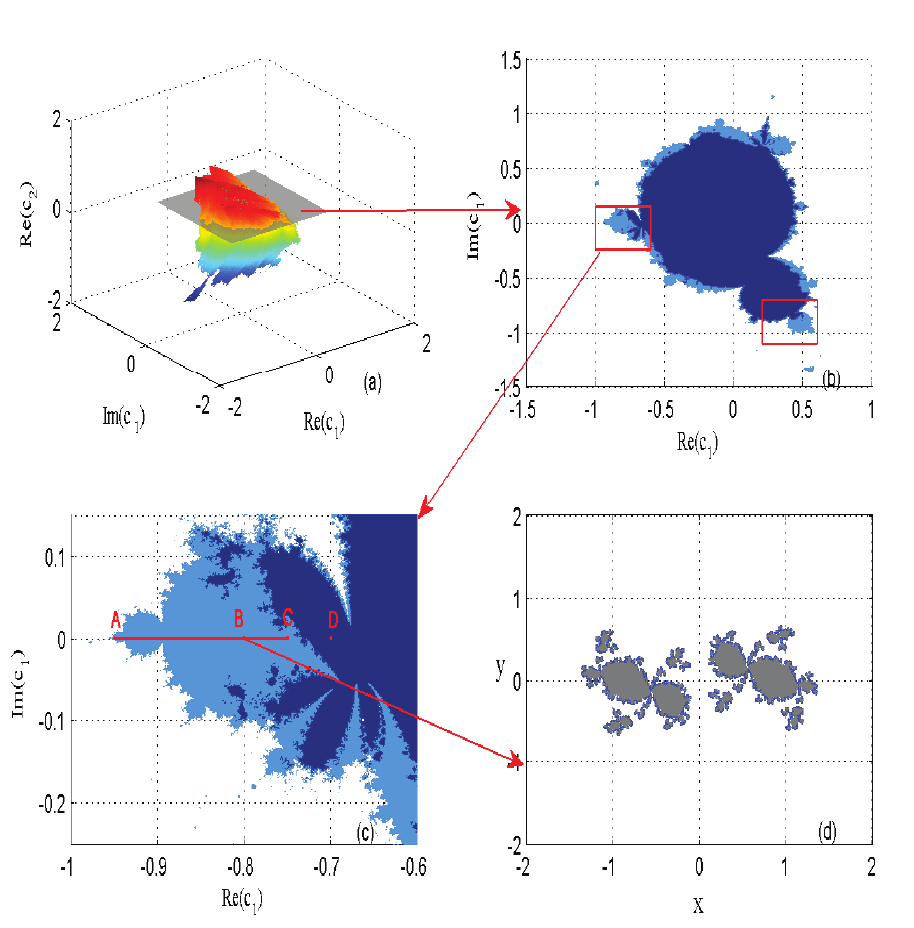
Figure 4. ( a ) The spatial CL ( F 1 ) with Im ( c 2 ) = 0.3 ( Im is the imaginary part). ( b ) The 2 D slice of ( with Re ( c 2 ) = 0.32. ( Re is the real part). ( c ) The local enlarged region of ( b ). ( d ) The ∞ ) Im ( c M F 2 )= 0.3 filled Julia set K ( F 1 ) with B point parameter c 1 =